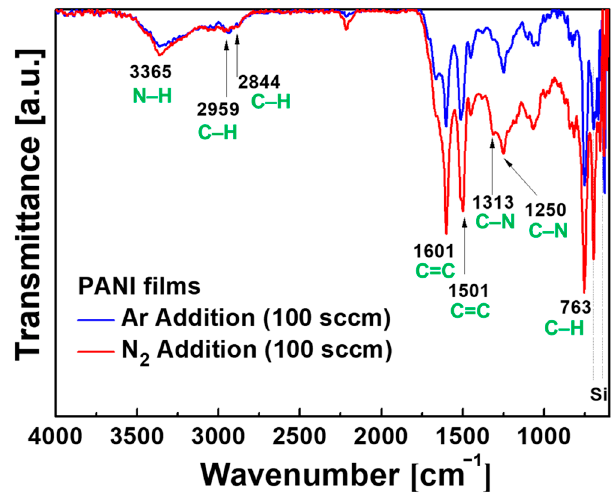
Figure 7. ATR-FTIR spectra of PANI films deposited with Ar and N 2 gases.